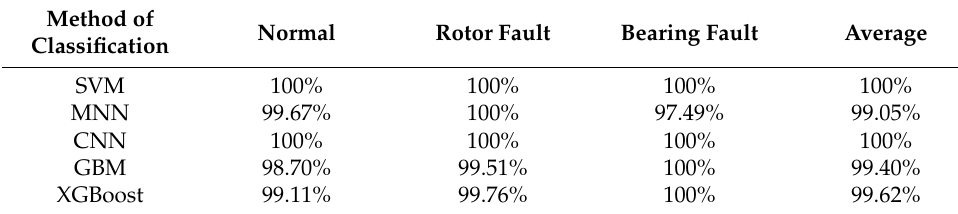
Table 12. Diagnostic accuracy of optimal SVM, MNN, CNN, GBM, and XGBoost models through stratified two-fold